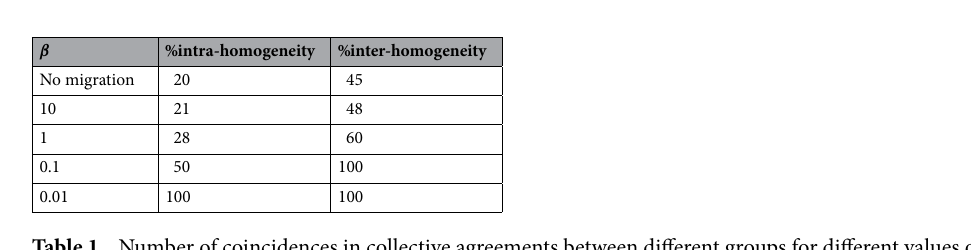
Table 1. Number of coincidences in collective agreements between different groups for different values of migration speed ( β